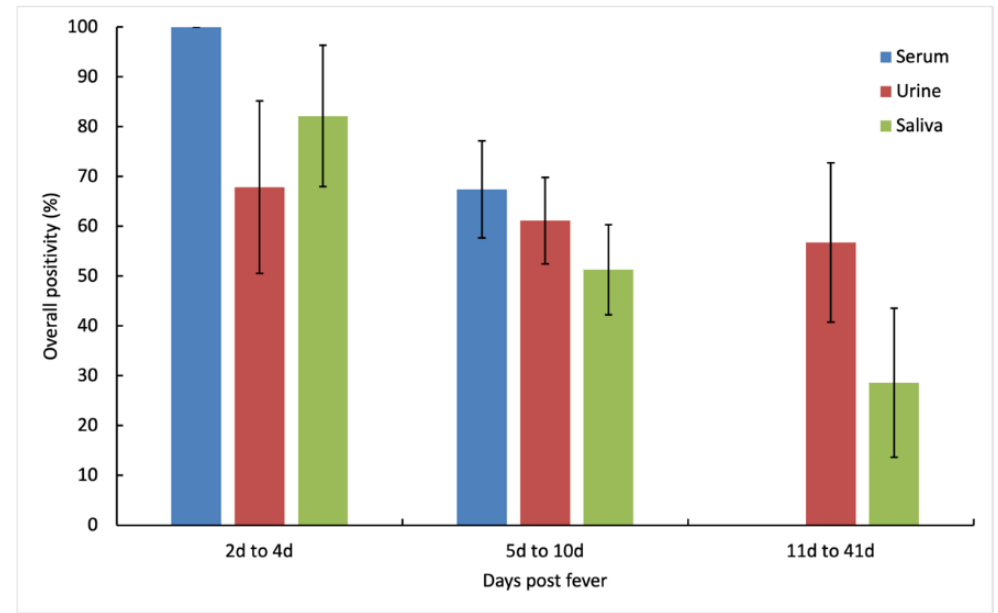
Figure 2. Overall positivity of DENV RNA in serum, urine, and saliva samples. From 2 days to 4 days after fever onset, serum showed the best overall positivity followed by saliva and urine, whereas from 5 days to 10 days after fever onset, urine showed better overall positivity than saliva. Urine was also the best sample for detecting DENV RNA from 11 days to 41 days after fever onset. The whiskers represent 95% CI for each sample.